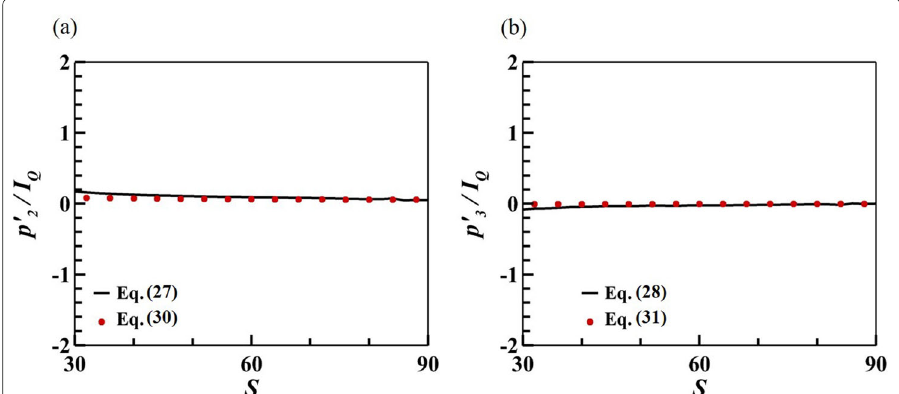
Figures 7 and 8 show the variations in the sound pressures with the observer distances along the directions with θ = 45 ◦ and θ = 90 ◦ , respectively. The convecting Mach num- ber is set as M a = 0.2. We plot the sound pressures at the same non-time dimensional time t = 120 as that for the case shown in Fig. 4. For θ = 45 ◦ , the variations in the sound pressure computed by using Eqs. (27) and (30) are shown in Fig. 7(a). Similar to those converges to the sound pressure p (cid:2) as the plotted in Fig. 4(a), the sound pressure p (cid:2) 2,appr 2 and p (cid:2) observer distance S increases. The difference between the sound pressure p (cid:2) 2,appr 2 is less than 5% of I Q ( x ) at the same position when S > 42. The variations in the sound pressure computed by using Eqs. (28) and (31) are shown in Fig. 7(b). The sound pres- converges to the sound pressure p (cid:2) as the observer distance S increases. The sure p (cid:2) 3,appr 3 and p (cid:2) is less than 5% of I Q ( x ) at the same difference between the sound pressure p (cid:2) 3,appr 3 position when S > 39. For θ = 90 ◦ , the variations in the sound pressure computed by